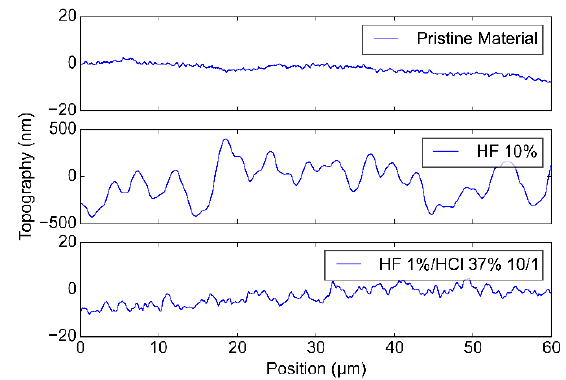
Fig. 3. Surface topography of Eagle2000 with a pristine surface, after being etched in HF 10%, and after being etched in HF 1%/HCl 37% for a volume ratio of